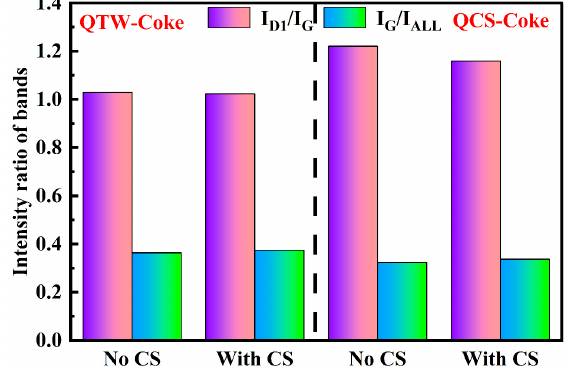
Figure 9. Intensity ratio of the fitted bands of Raman spectra.